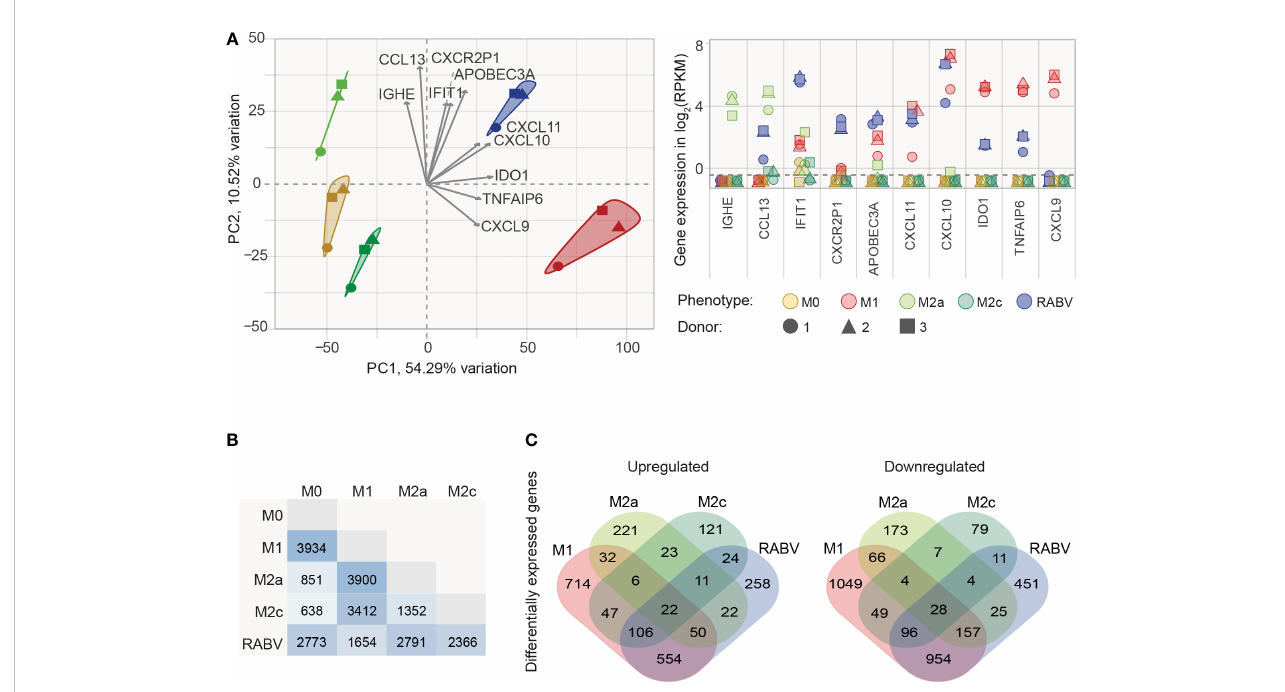
FIGURE 2 Initial analysis of the similarities and differences between the M0, M1, M2a, M2c and RABV macrophage gene expression pro fi les. All genes that are substantially expressed in at least one of the phenotypes (mean RPKM > 0.5) were submitted in a principal component analysis (A) , showing the two components responsible for the majority of variation (PC1 and PC2) and the top 10 active variables that contribute the most to this variation (highest cos 2 values, grey arrows). The expression levels of these 10 genes for every individual samples in shown in the right graph, in log 2 RPKM. The number of differentially expressed genes (DEGs, p adj < 0.05, log 2 fold change < -1 or > 1) between the fi ve different macrophage phenotypes is shown in (B) , as well as the number of upregulated or downregulated DEGs when compared to M0 (C)